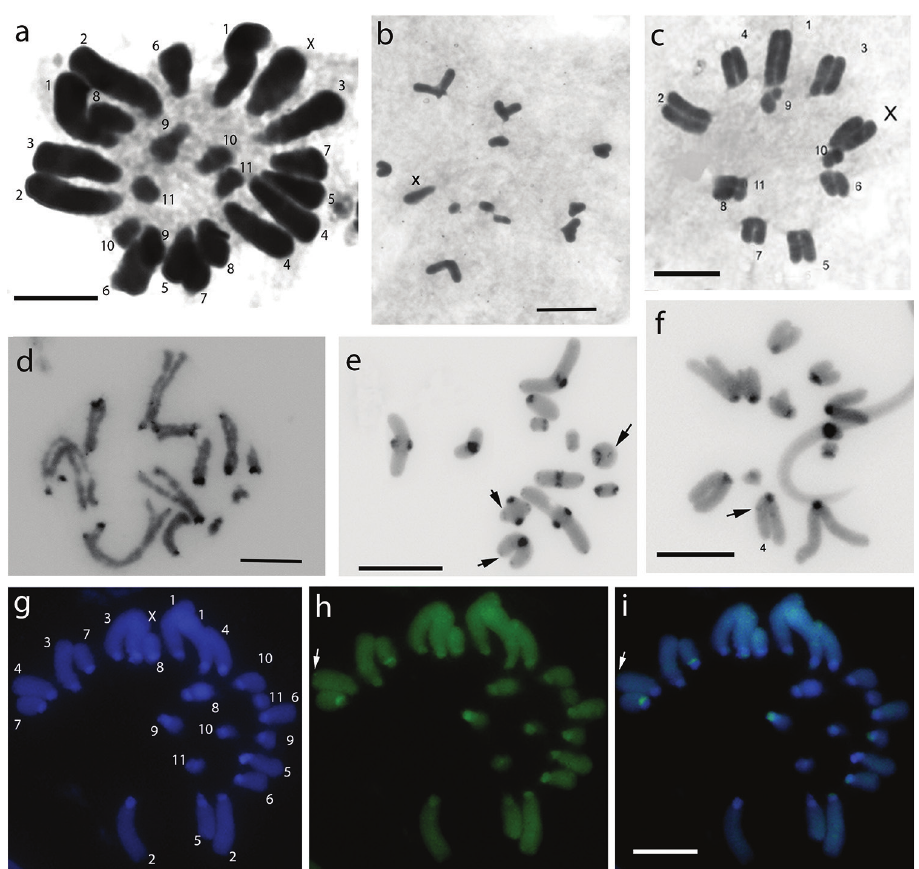
Figure 1. Mitotic and meiotic stages of Abracris flavolineata by Giemsa conventional staining ( a–c ), C-banding ( d–f ) and fluorochromes staining ( g–i ): a mitotic metaphase b diakinesis c metaphase II d pachytene e diakinesis f metaphase II g mitotic metaphase by DAPI staining h mitotic metaphase by CMA staining i overlapping DAPI/CMA . The numbers correspond to autosomes. X corresponds to the 3 3 sex chromosome. The arrows indicate the discrete heterochromatic bands. Bar=